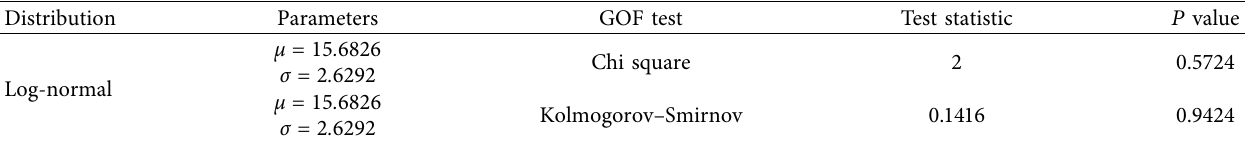
Table 12: Cyber-related data breach loss severity distribution of GOF test.